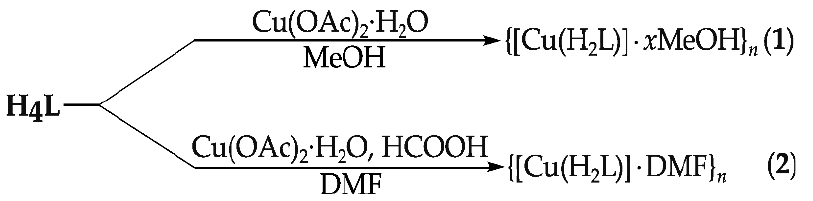
4 L and compounds 1 and 2